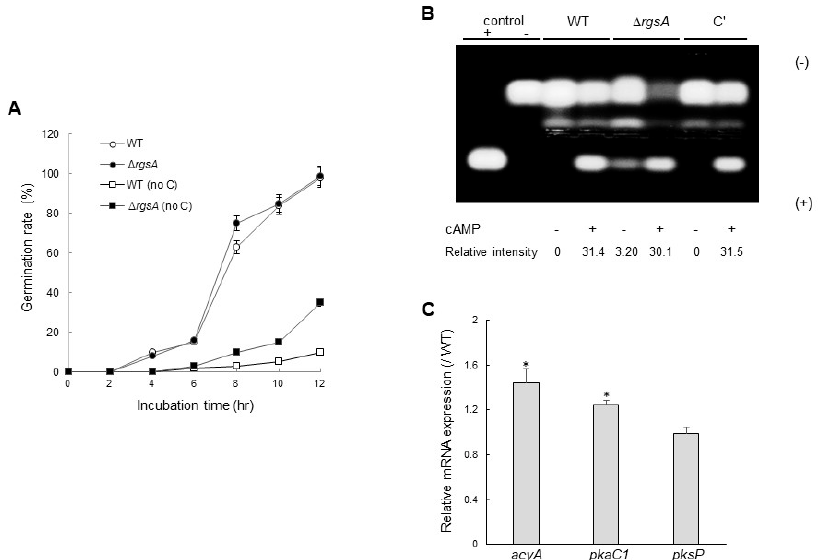
Figure 2. The role of RgsA in spore germination and the cAMP-PKA signaling pathway. ( A ) Kinetics of germ tube outgrowth of WT and ∆ rgsA strains inoculated in liquid MMG at 37 ◦ C in the presence or absence of glucose. ( B ) PKA activity of WT (AF293), ∆ rgsA , and complemented (C (cid:48) ) strains, as monitored by gel electrophoresis. A phosphorylated substrate migrates toward the + anode. Each strain was grown in MMG for 3 days at 37 ◦ C and mycelial extract was analyzed. ( C ) Levels of acyA , pkaC1 , and pksP mRNA in three strains analyzed by qRT-PCR. * p <